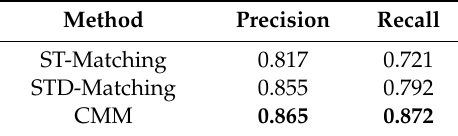
Table 6. Precision and Recall on Real GPS Trajectory